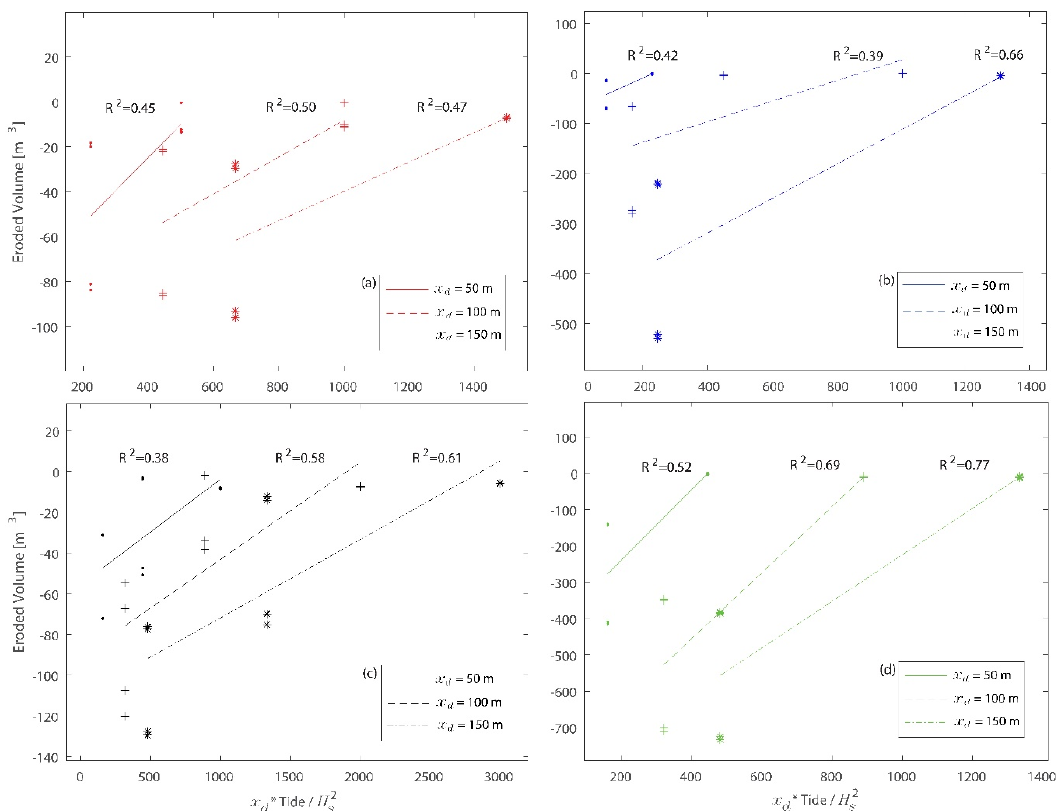
Figure 8. Eroded marsh volume for those configurations which cause erosion (see Figure 7), as function of the dimensionless variable x d *Tide/ H s 2 . ( a ) slope = 0.4% and Tide = ±0.4 m ( b ) slope = 0.8% and Tide = ±0.4 m ( c ) slope = 0.4% and Tide = ±0.8 m ( d ) slope = 0.8% and Tide = ±0.8 m . Tide = ± 0.4 m ( c ) slope = 0.4% and Tide = ± 0.8 m ( d ) slope = 0.8% and Tide = ± 0.8 m. Water 2020 , 12 , x FOR PEER REVIEW